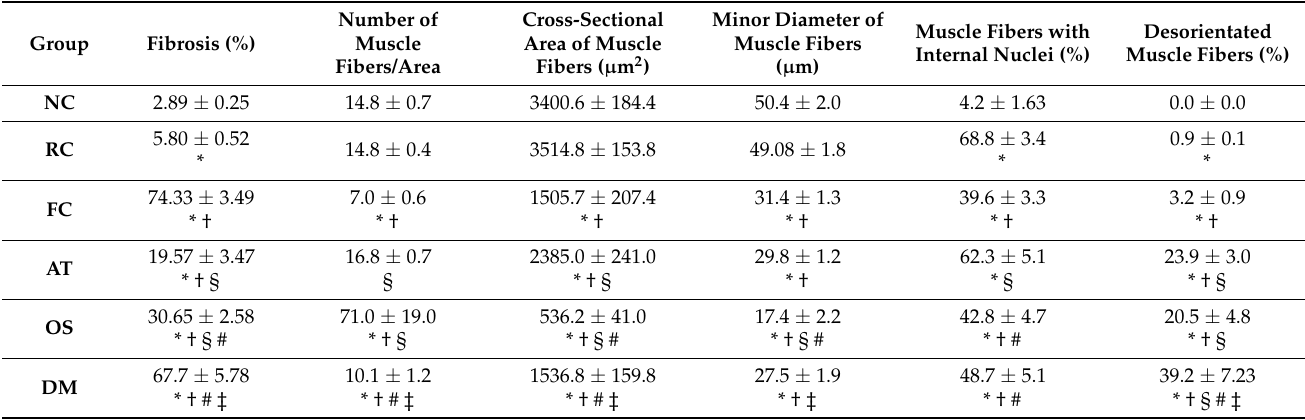
Table 2. Histomorphometric characteristics of the neomuscle formed within VML injury with the tissue/biomaterial used after 60 days of